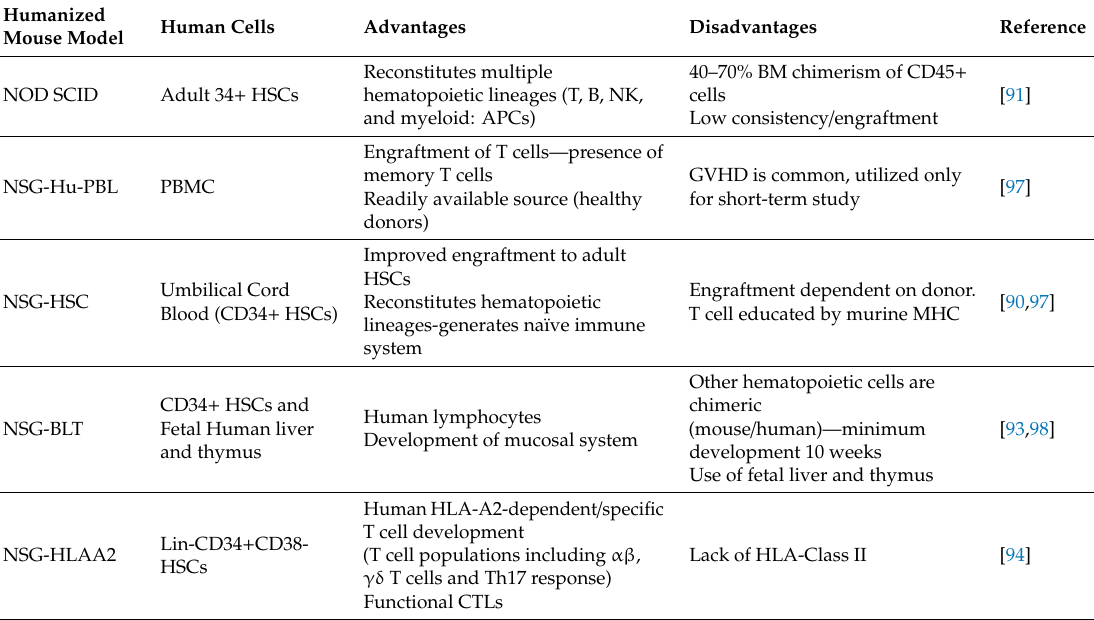
Table 3. Brief summary of humanized mouse models